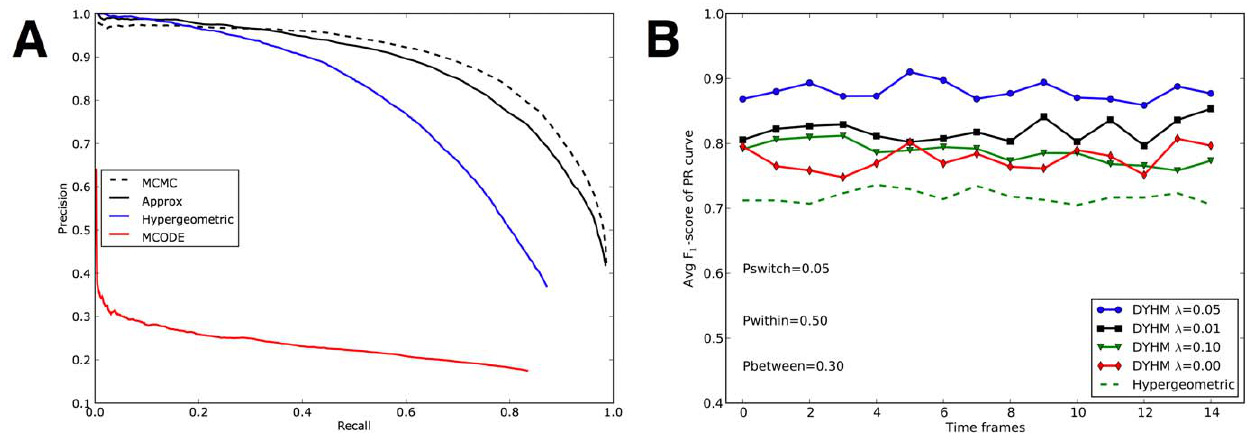
Figure 1. Simulation study. (A) Comparison on static synthetic networks. From top to bottom, lines correspond Precision-Recall curves of four different methods. Dashed black : Hierarchical model trained by MCMC sampling. Solid black : Hierarchical model trained by variational approximation. Solid blue : Hypergeometric method [17]. Solid red : MCODE [16]. (B) Comparison on dynamic synthetic networks. From top to bottom, lines denote correspond to F 1 scores over time frames. Blue circle : DYHM with l ~ 0 : 05 . Black squre : DYHM with l ~ 0 : 01 . Green triangle : DYHM with l ~ 0 : 1 . Red diamond : DYHM with l ~ 0 . Dashed green : Hypergeometric method [17] applied separately to each each time frame.